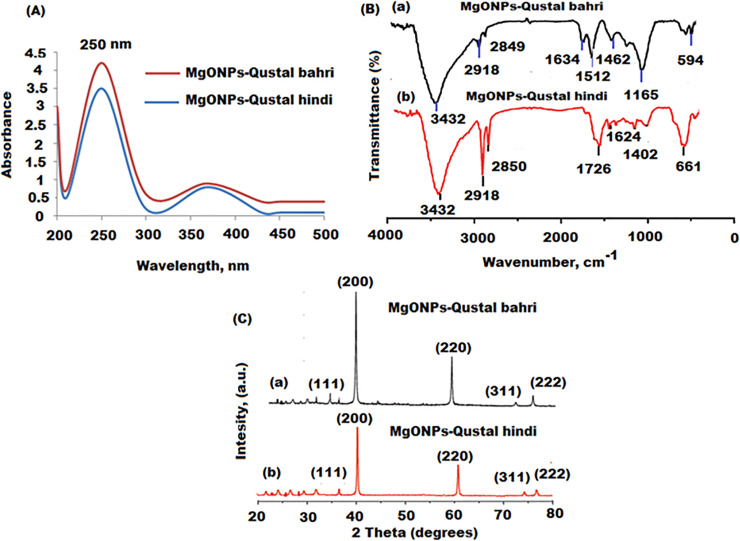
(A) UV-Vis, (B) FT-IR and (C) XRD spectra of MgONPs synthesized with S.costus (Qustal hindi and Qustal bahri) biomasses, respectively.